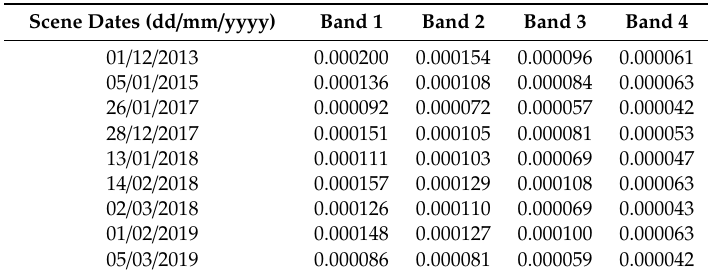
Table 2. The noise equivalent di ff erence in reflectance (NE ∆ R rs ), computed from a kernel of 33 × 33 pixels from an optically deep and homogeneous area, for each image used in this study.